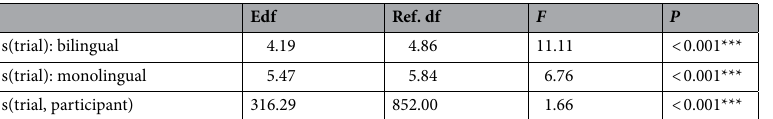
Table 1. Approximate significance of smooth terms (outcome variable: number of switches per s). Parametric coefficients: intercept = 0.63 ( SE = 0.02, t = 26.81, p < 0.001); monolingual = − 0.05 ( SE = 0.05, t = − 1.06, p = 0.287). GCV = 0.09, adjusted R 2 = 0.48, deviance explained = 57.2%. *** p < 0.001.